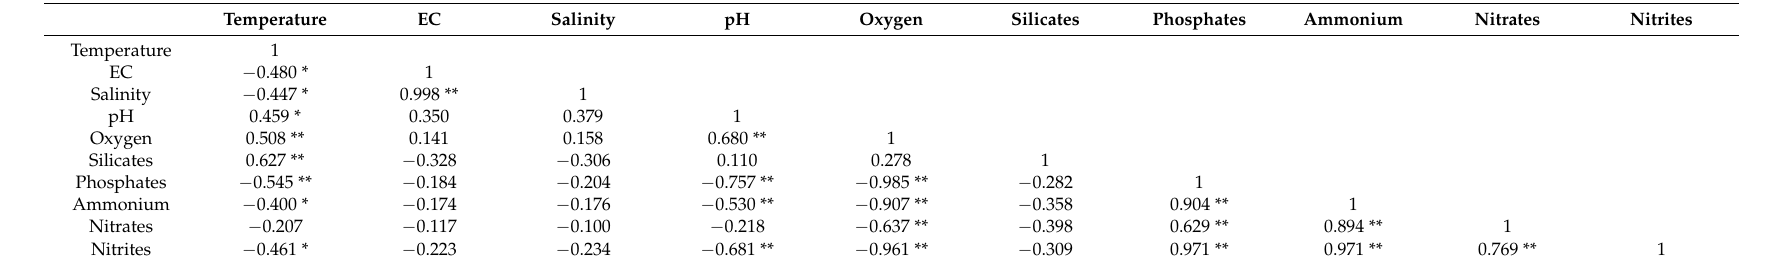
Table 2. Pearson’s correlation matrix for the physicochemical